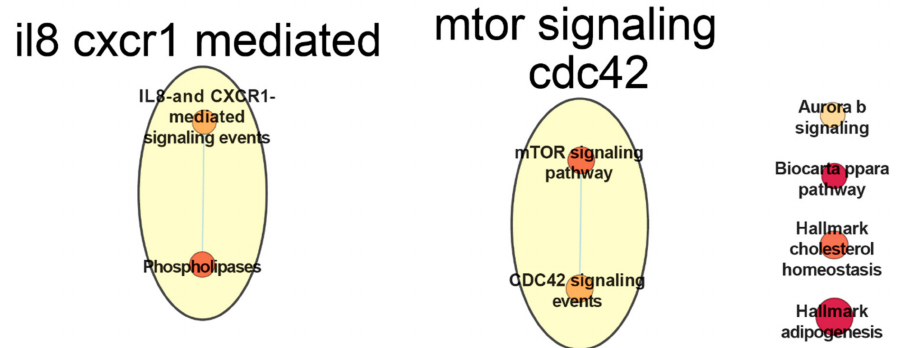
Figure 7. Top predictive features for IGHV-mutated CLL patients. Each node shows a predictive pathway features and edges connect shared members of pathways. Node fill uniformly indicates highest score; yellow = netDx score 3, red = netDx score 10. Selected features required a minimum feature score of 9 out of 10 in at least in 50% of train/test